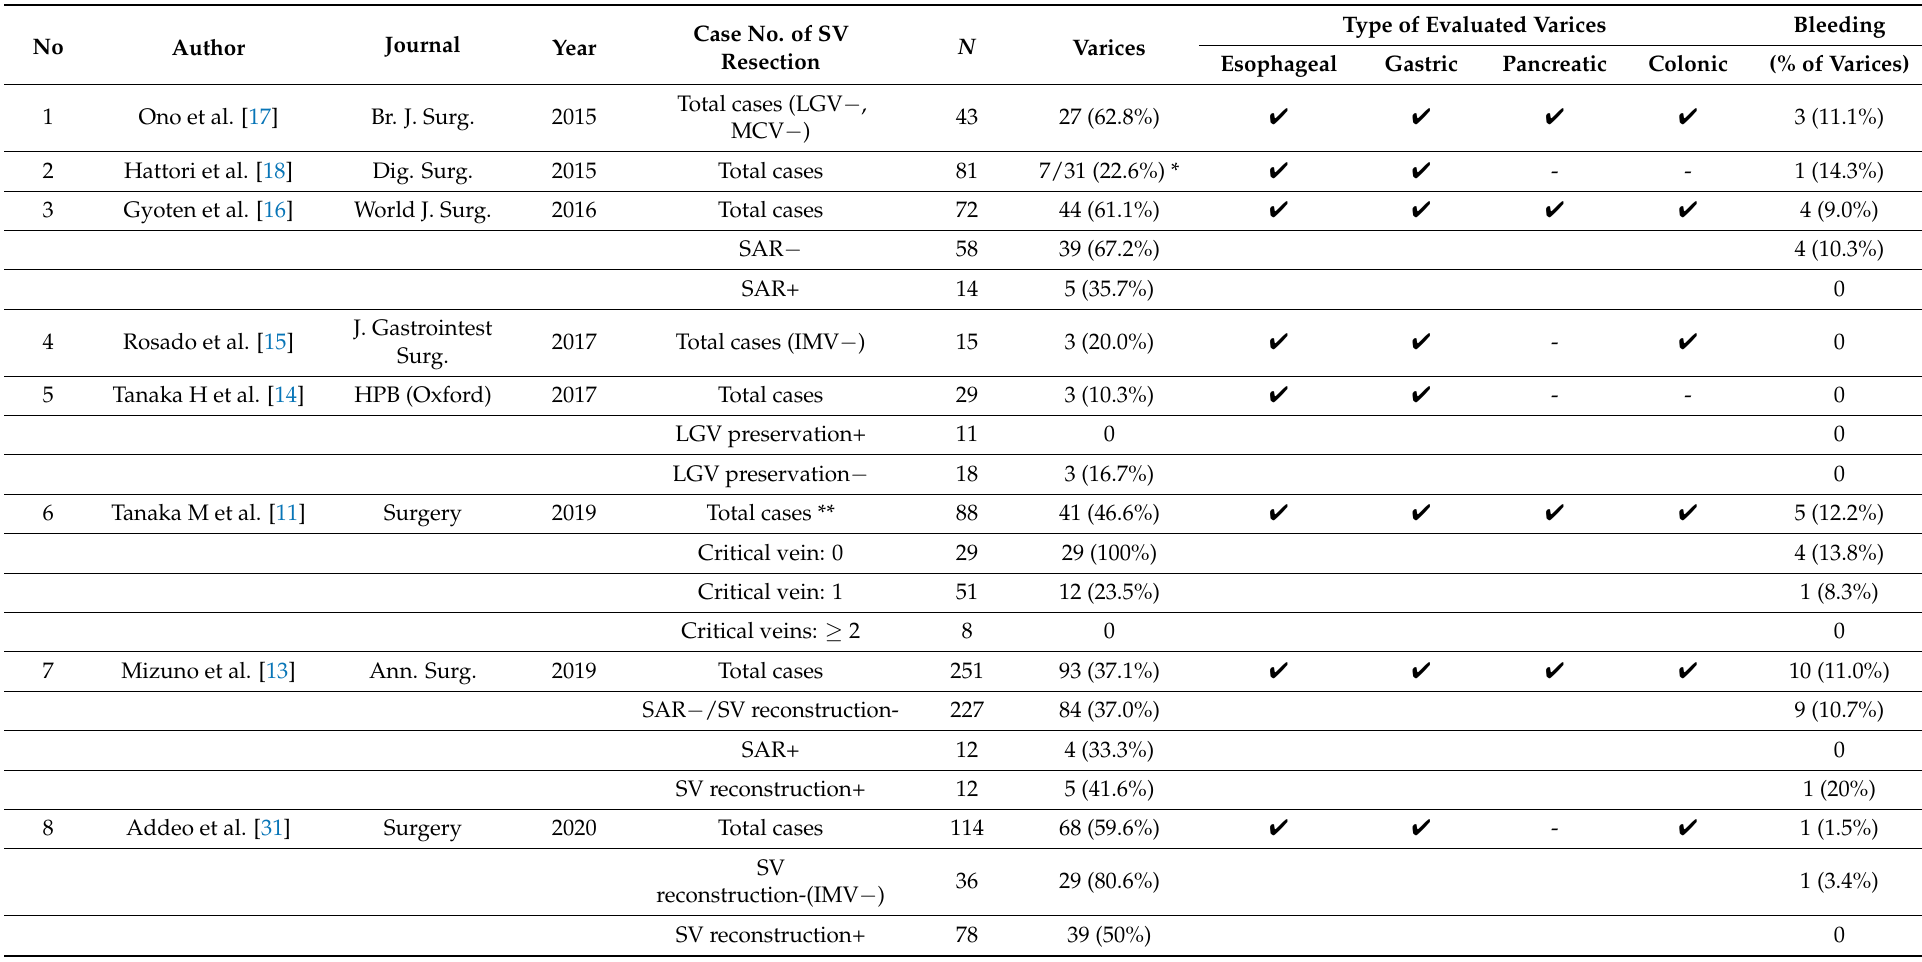
Table 1. Frequency of variceal formation and gastrointestinal bleeding after PD with SV